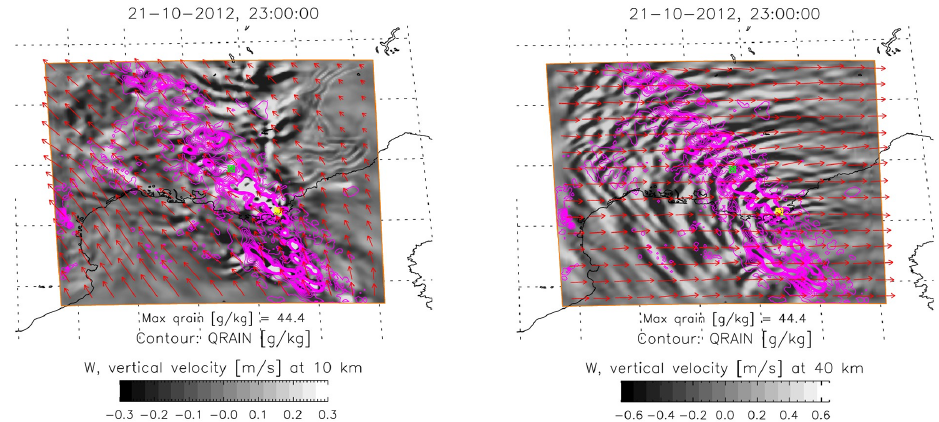
Figure 7. Horizontal cross section of wind vertical velocity, w (ms − 1 ), for 21 October 2012 at 10km (left) and 40km (right) of altitude. Arrow’s length is proportional to the horizontal wind intensity (0.1 ◦ of latitude or longitude is equal to 10ms − 1 ). Contour lines represent the total column rain water mixing ratio, qrain (gkg − 1 ), by steps of 1gkg − 1 .